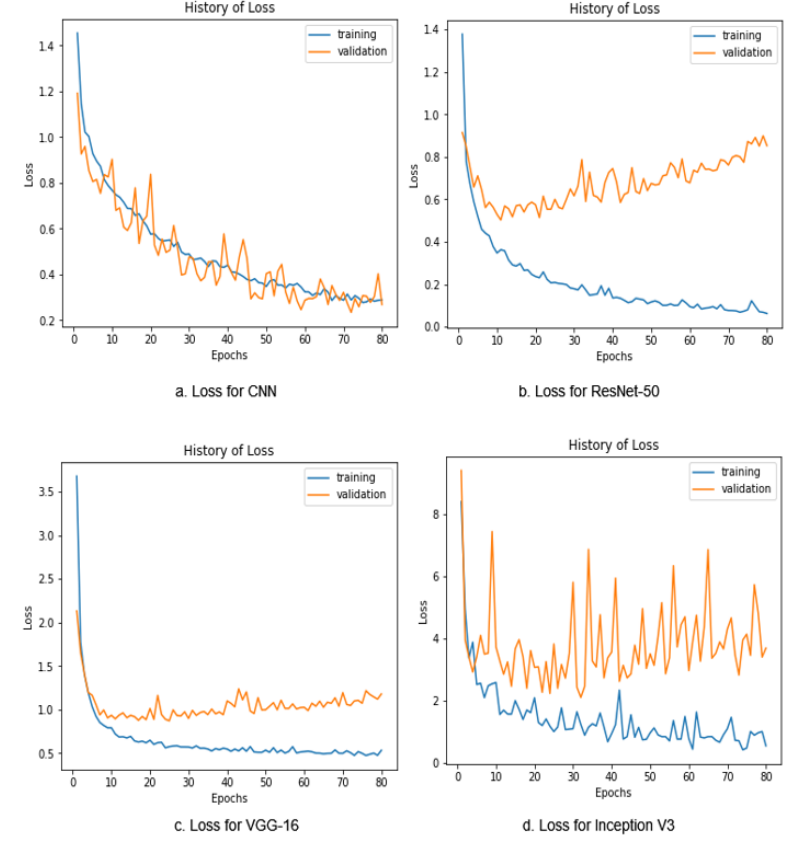
Figure 11. Loss graph for the CNN, ResNet-50, Inception V3, and